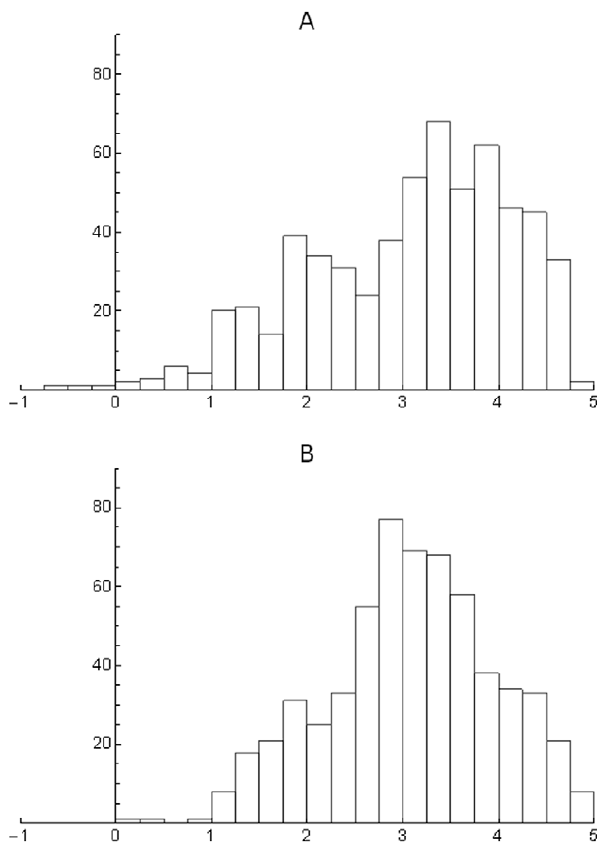
Figure 10. Distribution of mean covariances in the data (A), and in one instance of the null model (B).